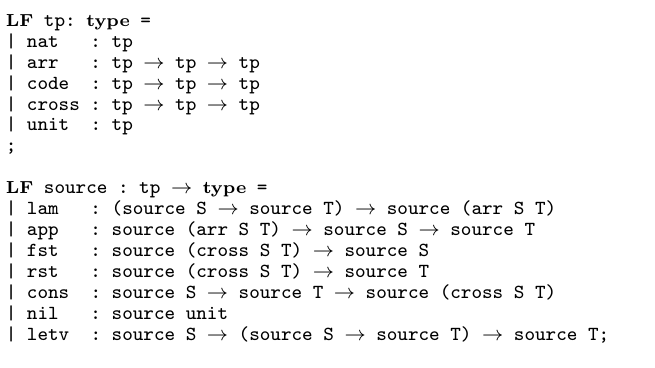
Fig. 3. Encoding of the source language in